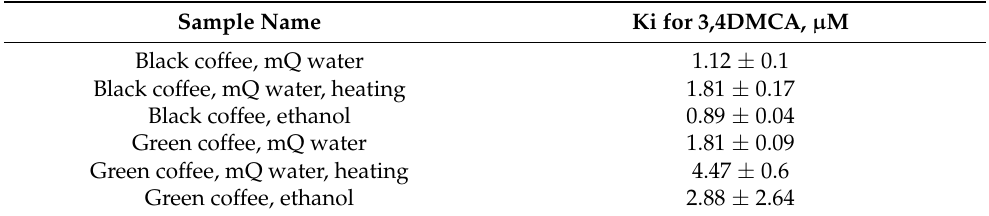
Table 4. Values of the alpha-synuclein fibrillization inhibition constant for 3,4DMCA in different coffee